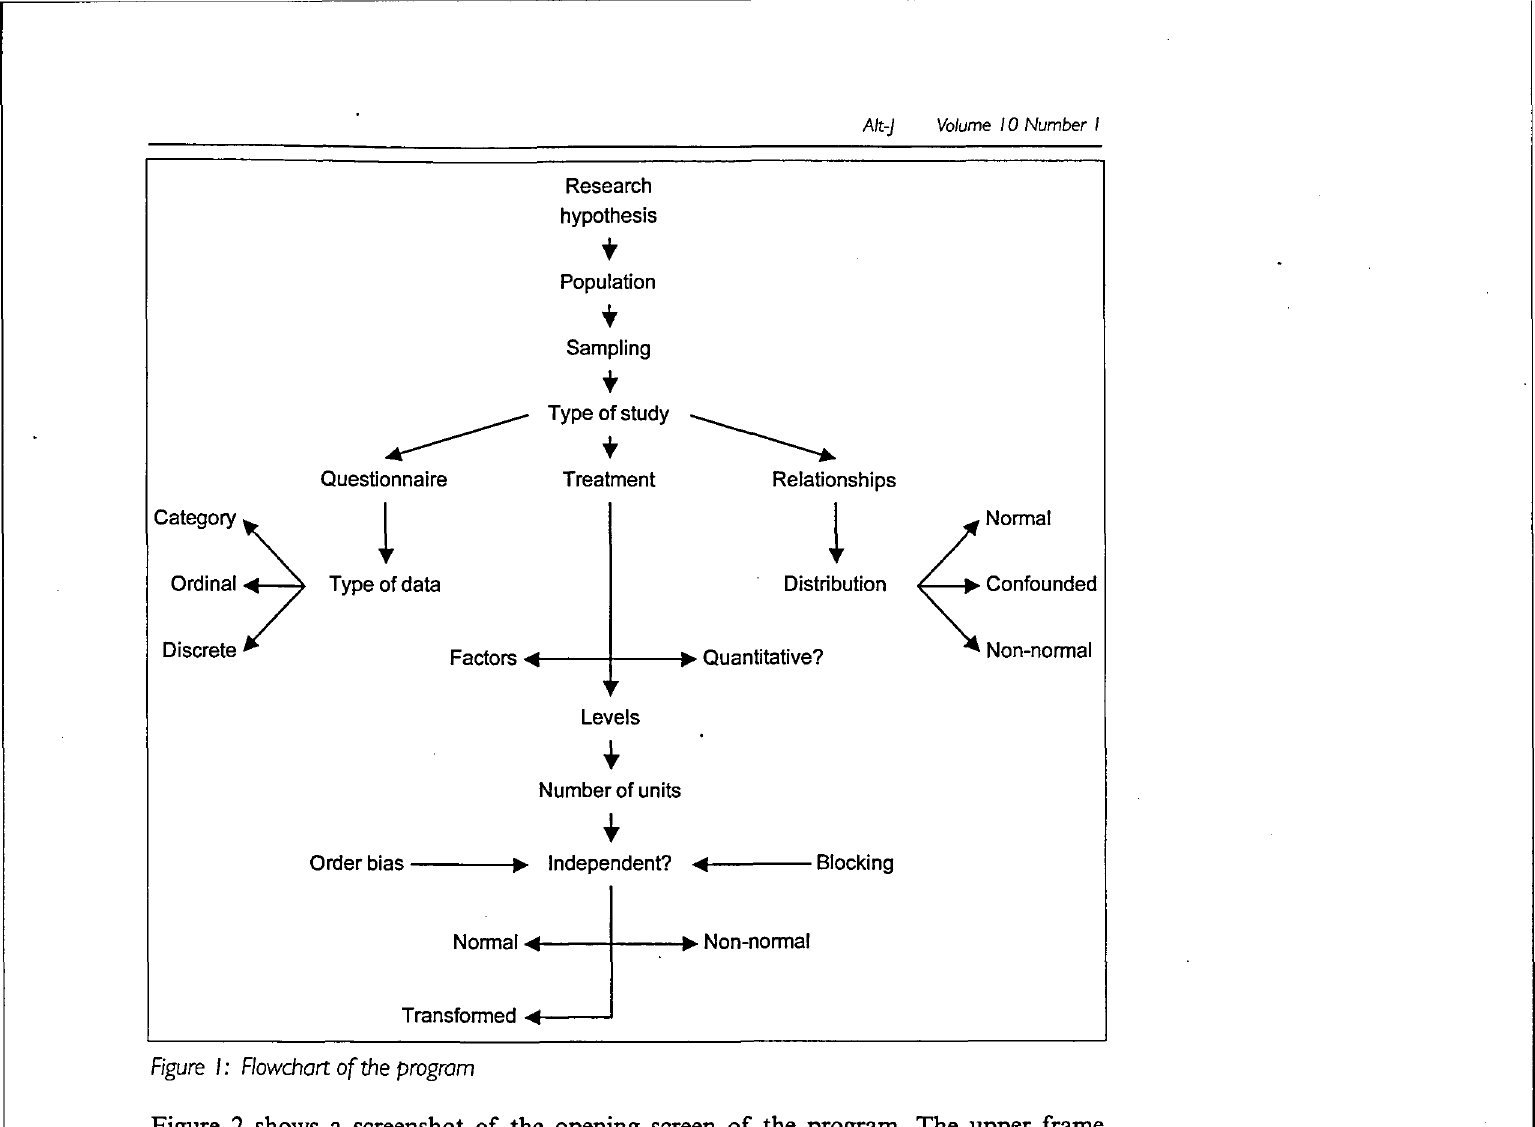
Figure I: Flowchart of the